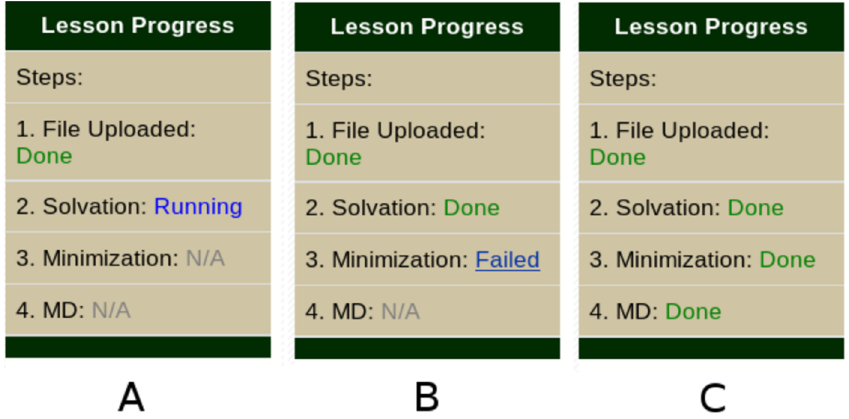
Figure 2. The lesson status bar of CHARMMing, which is displayed below the standard status bar. Panel A shows a lesson with solvation running, panel B shows an error condition, and panel C shows the status bar when the lesson is